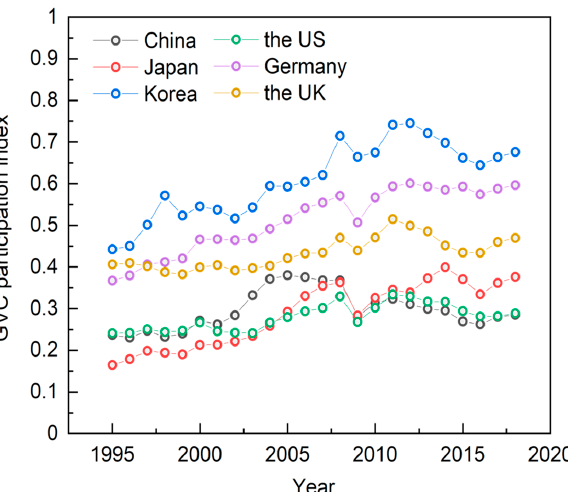
Figure 3. Trends in the GVC participation index of manufacturing in major global economies, 1995– 2018. Data source: Authors’ calculations based on UIBE database.